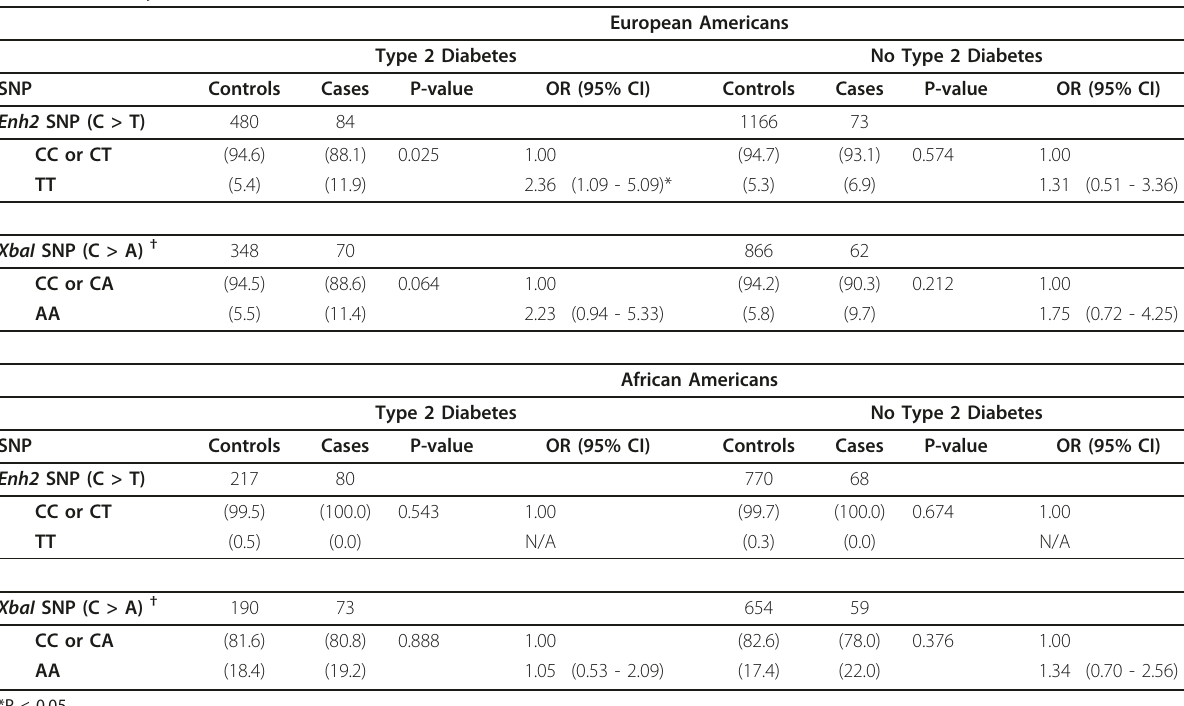
Table 2 Stage 1 GLUT1 Enh2 and XbaI Risk genotype distributions among case and control subjects and odds ratio of albuminuria, by diabetes and race